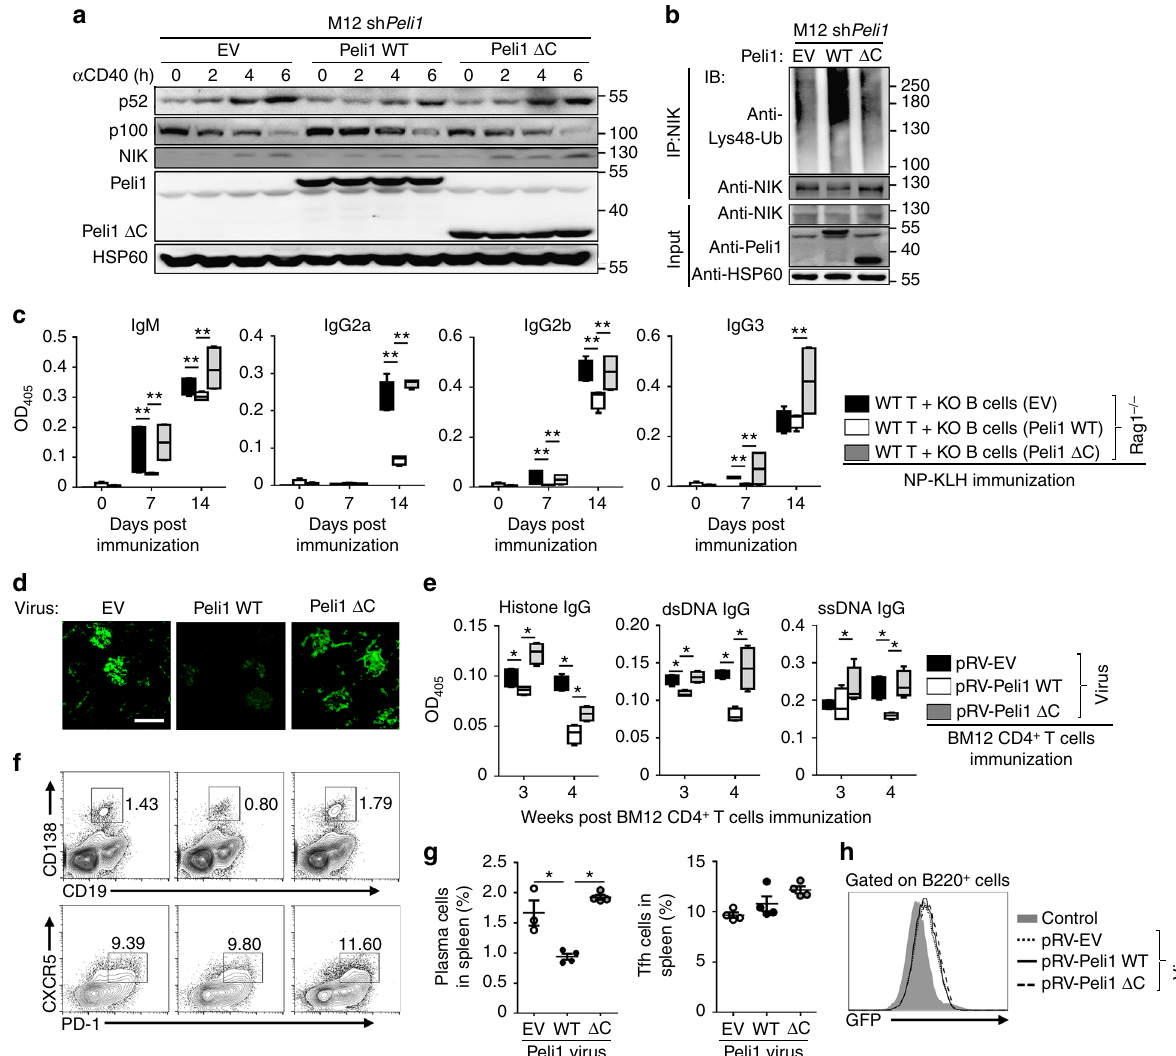
Fig. 7 Overexpression of Peli1 prevents lupus-like disease. a Immunoblot analysis of p52, p100, NIK, Peli1, Peli1 Δ C and HSP60 in Peli1 -knockdown M12 cells that reconstituted with empty vector (EV), WT full-length Peli1 or Peli1 Δ C that stimulated with anti-CD40 ( α CD40) at the indicated time points. b Analysis of Lys48 ubiquitination of NIK in Peli1 -knockdown M12 cells reconstituted with EV, WT Peli1, or Peli1 Δ C that stimulated with anti-CD40 ( α CD40) for 4 h in the presence of MG132. c LISA of NP-speci fi c IgM, IgG2a, IgG2b and IgG3 in the serum of Rag1 − / − mice that transferred with WT T cells plus KO B cells reconstituted with EV, WT Peli1 or Peli1 Δ C, and then immunized intraperitoneally with NP-KLH. d – h Peli1 -de fi cient (KO) mice were immunized with 7.5 million of BM12 CD4 + T cell to induce lupus-like disease, and then injected with pRV-GFP retrovirus encoding Peli1 or Peli1 Δ C 12 h post-immunization. The IgG deposits in kidney were examined by staining with Alexa Fluor 488-labeled anti-mouse IgG ( d ). Scale bar, 100 μ m. The anti-dsDNA, anti-ssDNA, anti- histone IgG in serum were determined by ELISA ( e ). The percentages of CD19 − CD138 + plasma cells, PD-1 + CXCR5 + Tfh cells ( f , g ) and infected B220 + B cells ( h ) in spleens were assessed by fl ow cytometry. Data are shown as the mean ± SEM based on three independent experiments. Two-tailed Student ’ s t- tests were performed. * P < 0.05 and ** P <